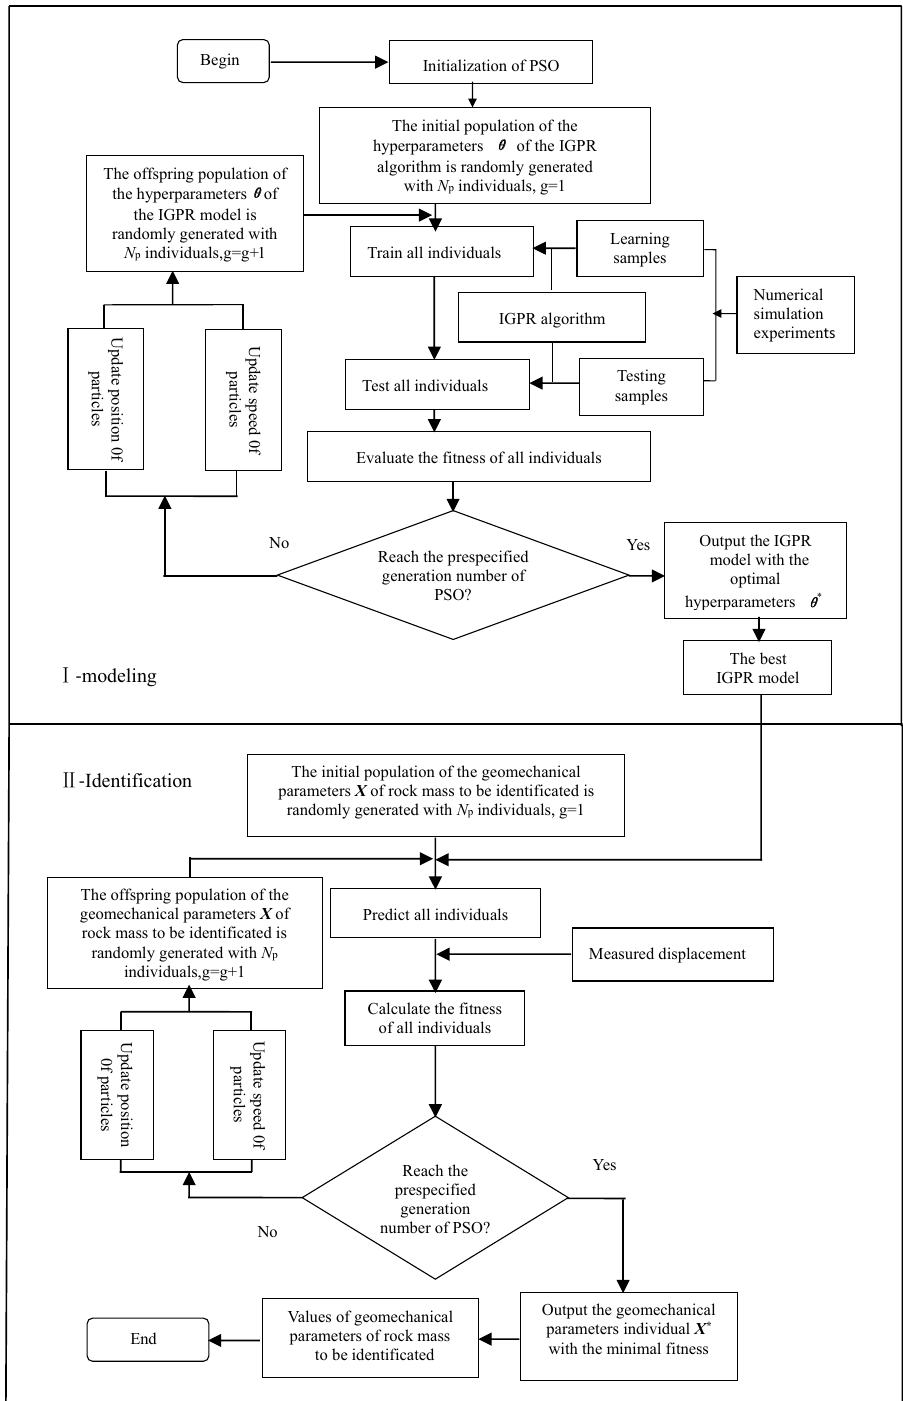
Figure 1. Whole flow chart of direct optimized displacement back analysis based on PSO-IGPR hybrid